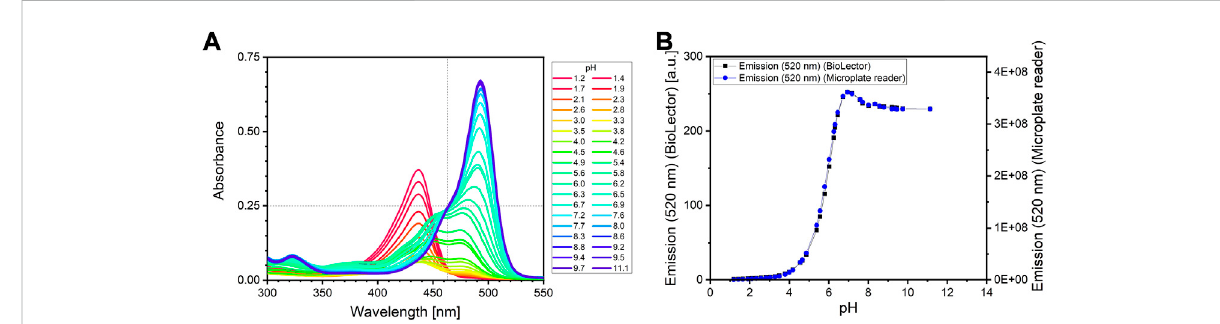
FIGURE 2 (A) Absorbance spectrum of a sodium fl uorescein solution at different pH. The isosbestic point was found at 463 nm (indicated be the dotted vertical line). The fl uorescein reagent is adjusted to an absorbance at wavelength 463 nm of 0.25 (indicated by the dotted horizontal line). Measurement of 200 μ L fl uorescein solution in a 96 well microplate ( μ clear, Greiner BioOne, Kremsmünster) using a microplate reader (SpectraMax iD3, Molecular Devices, United States). (B) Emission intensity of sodium fl uorescein at 520 nm after excitation at 488 nm at different